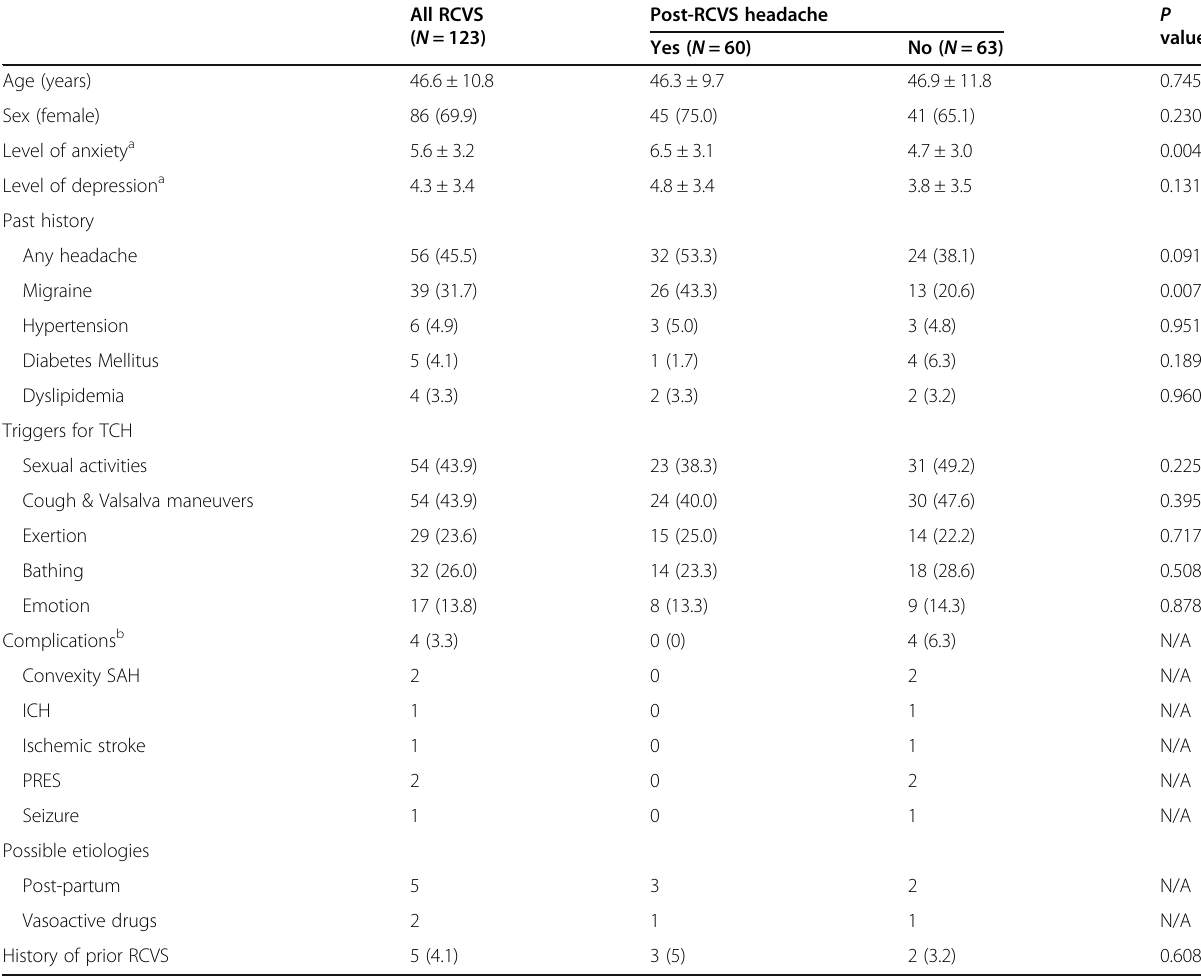
Table 1 Demographics and characteristics of RCVS patients